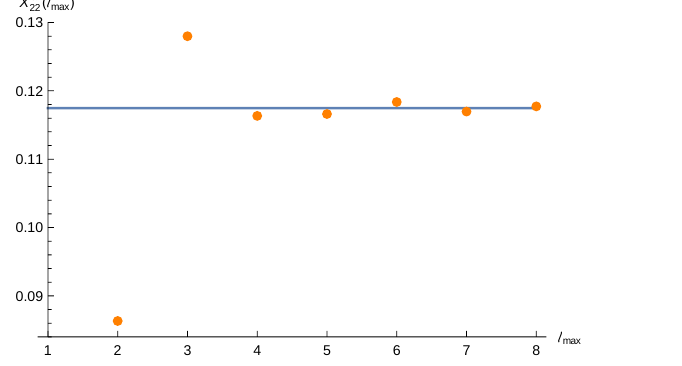
( ‘ max ) in the range [0 : 0425 ; 0 : 0650] plotted against ‘ max . Blue 22 . 22